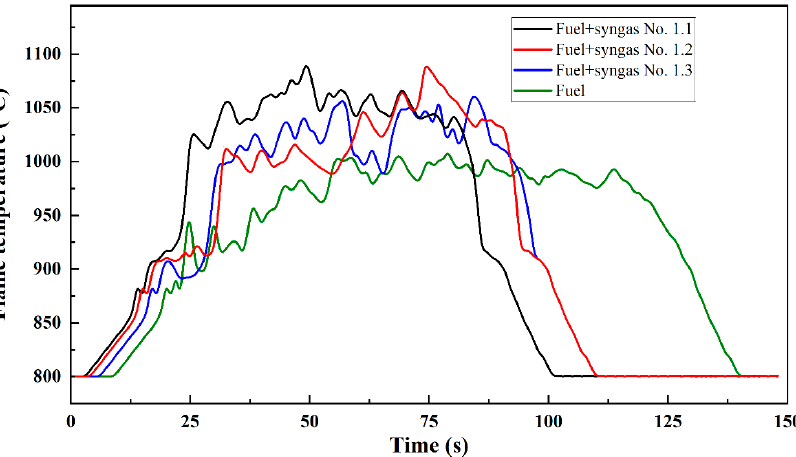
Figure 5. Typical temperature trends of flames during the CWS droplet combustion while adding synthesis gases of different compositions to the combustion chamber.